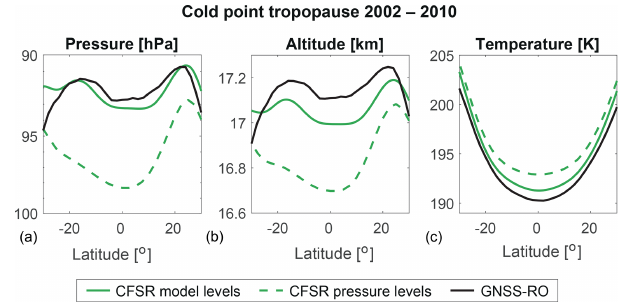
Figure 2. Latitudinal distributions of zonal-mean cold point tropopause pressure (a) , altitude (b) , and temperature (c) based on radio occultation data (black) and CFSR model-level (green solid) and pressure-level (green dashed) data during